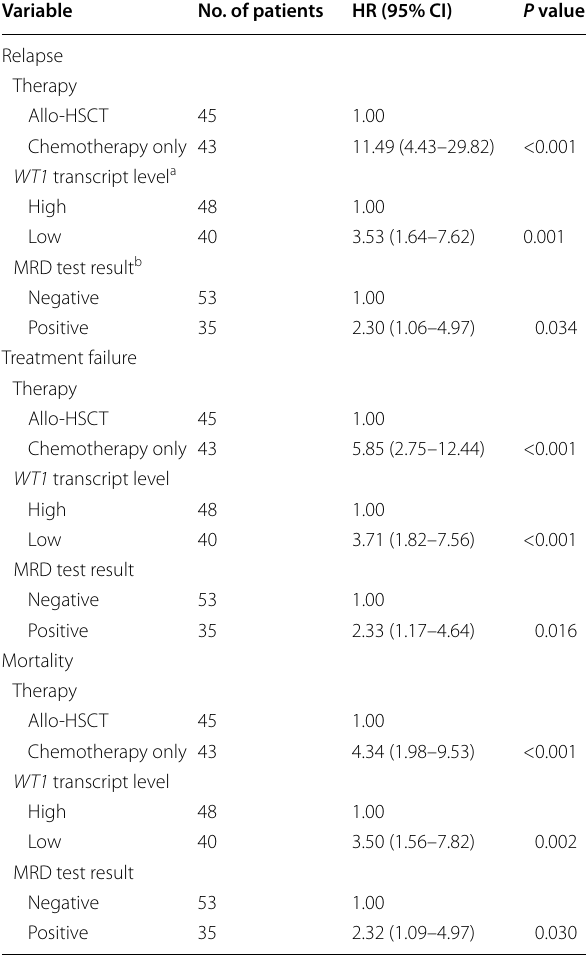
Table 3 Multivariate analyses of AML patients receiving chemotherapy only and allo-HSCT based on left-truncated Cox